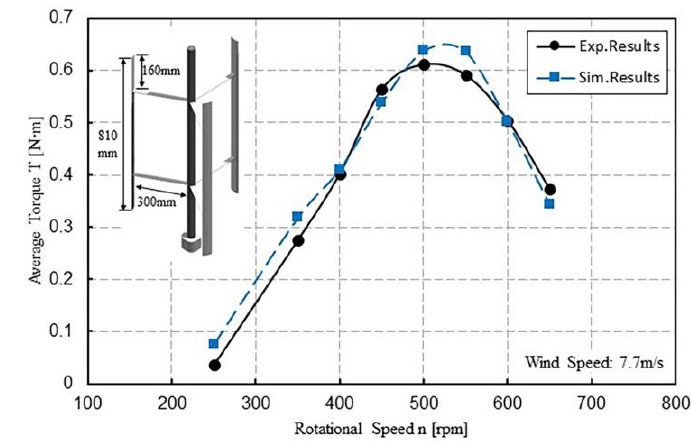
Figure 8. Experimentally obtained and numerically simulated torque as a function of rotational speed of an isolated vertical axis wind turbine (VAWT).